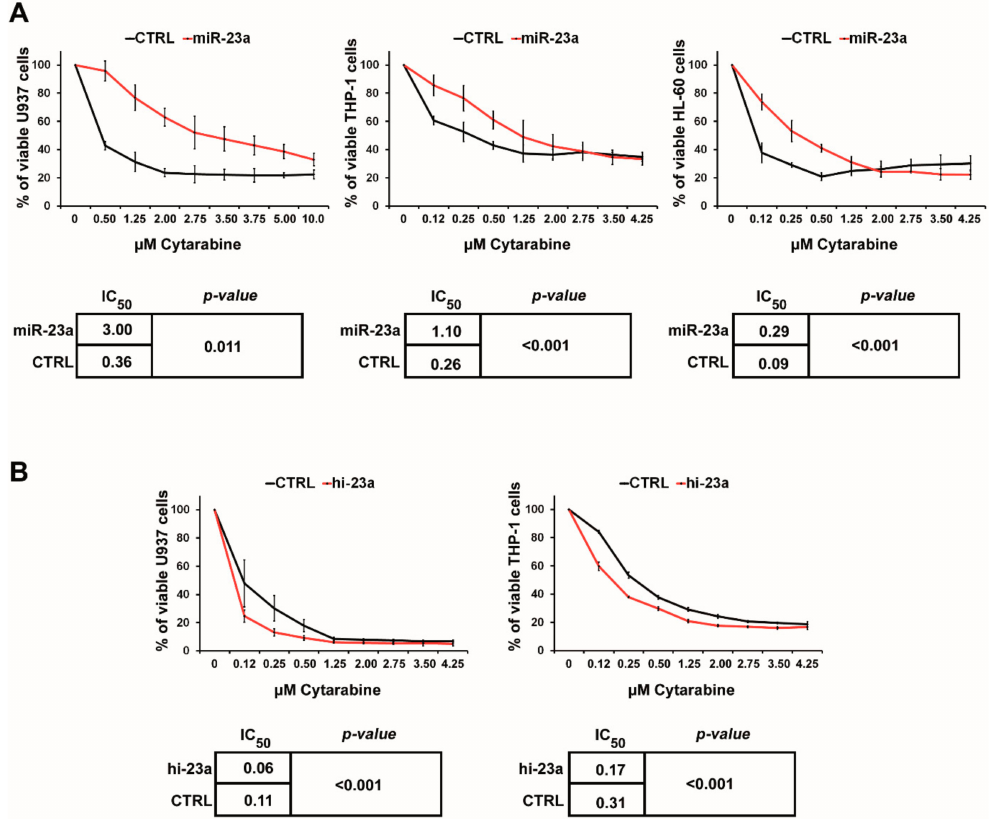
Figure 1. Sensitivity to cytarabine after miR-23a modulation in AML cell lines. ( A ) MTT cytotoxicity assays in AML cell lines after incubation with cytarabine. miR-23a denotes transfection / transduction with a miR-23a overexpression construct; CTRL denotes transfection / transduction with an empty control vector. ( B ) Experiments were repeated in AML cell lines with a knockdown of miR-23a, as achieved by the transfection of miR-23a hairpin inhibitors (hi-23a). Experiments were repeated at least three times. The curves depict the mean ± SD. Statistical significance between IC 50 values was calculated using Student’s t